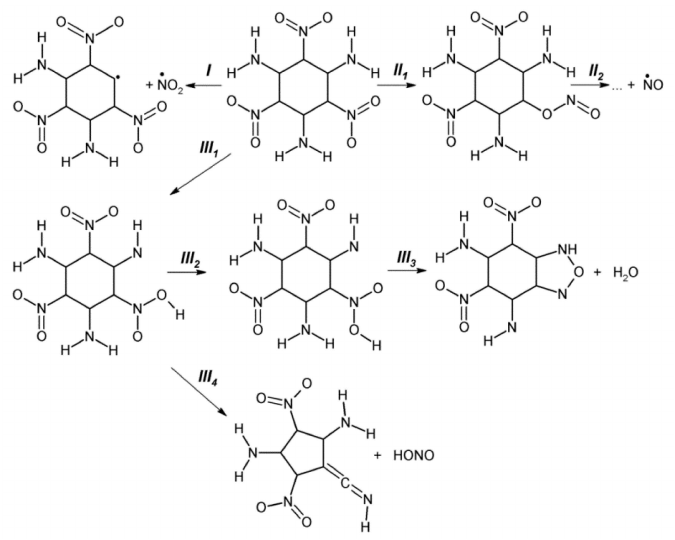
Figure 12. A schematic representation of TATB